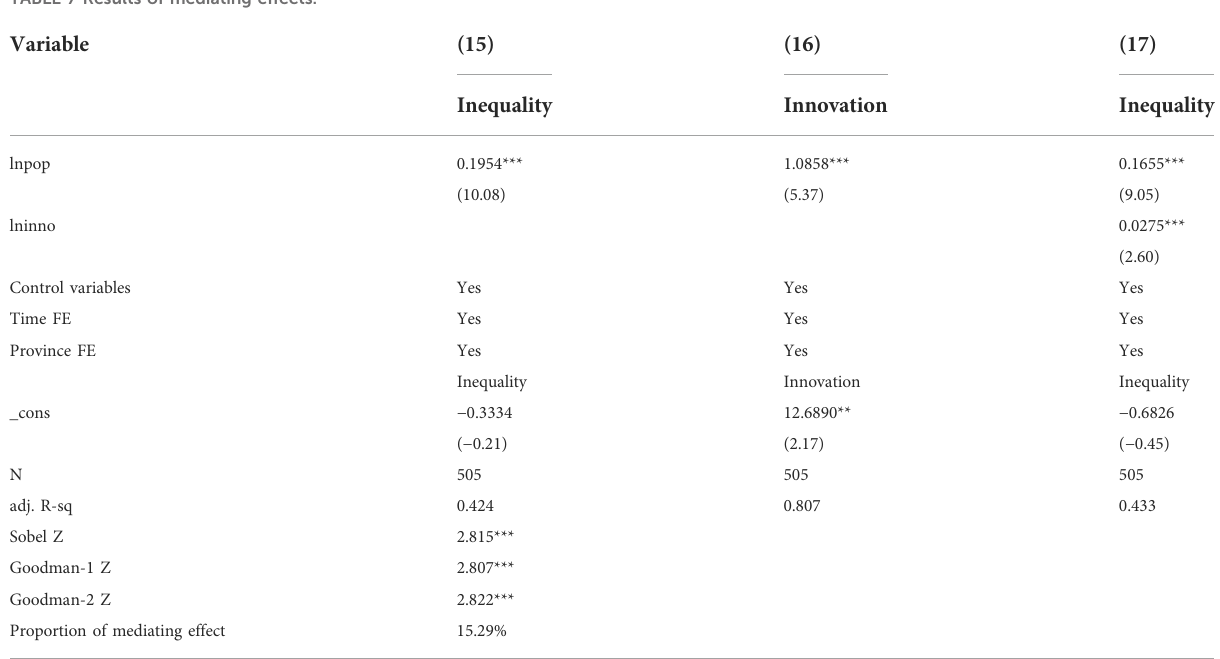
TABLE 7 Results of mediating